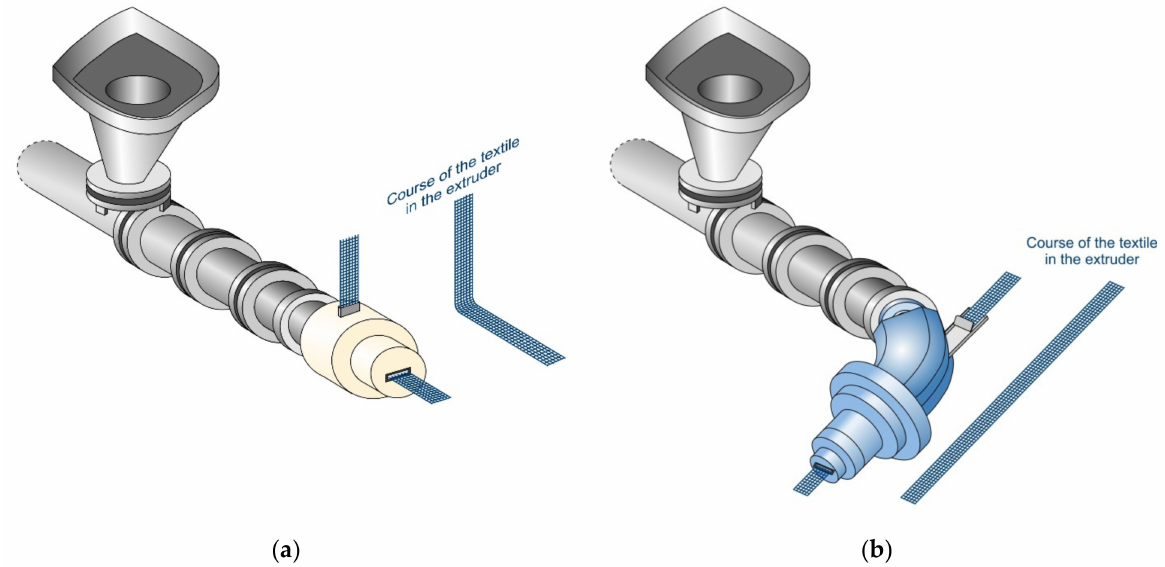
Figure 4. ( a ) Extruder with Mouthpiece 1 and vertical textile feed; ( b ) Extruder with Mouthpiece 2 and horizontal textile